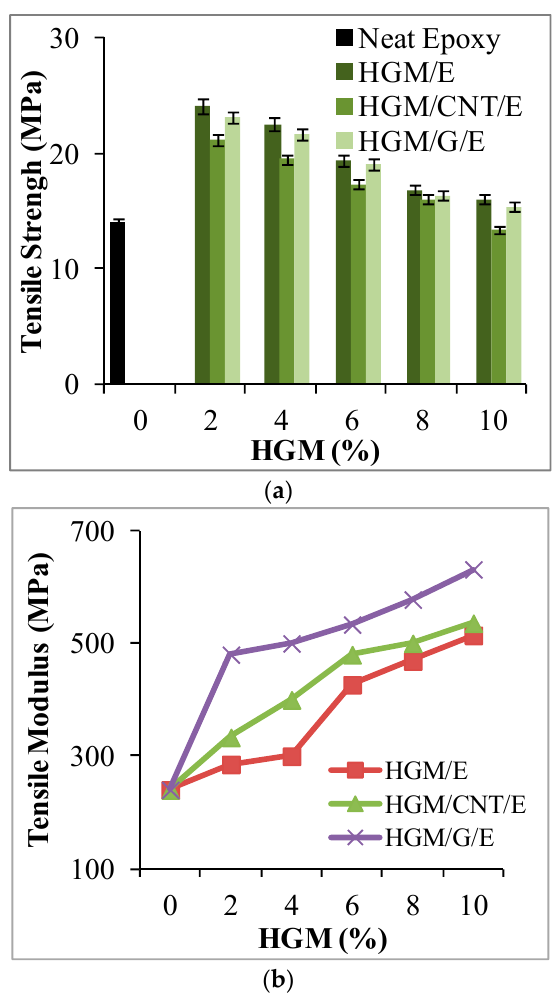
Figure 5. Tensile ( a ) modulus and ( b ) strength of composites.